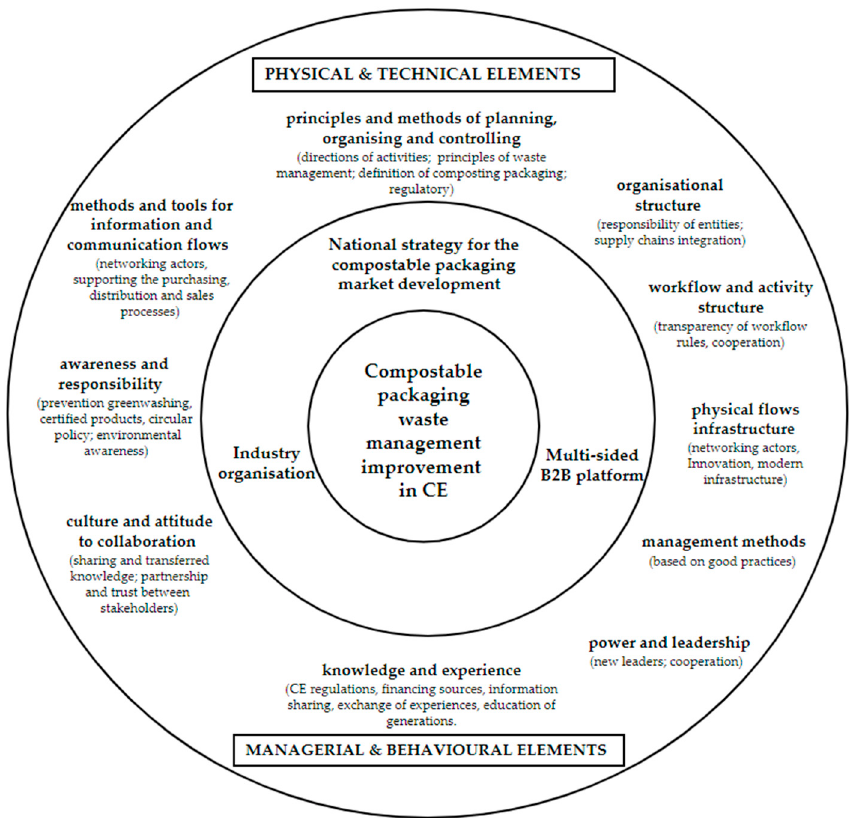
Figure 3. Multi-solution perspectives for improving compostable packaging waste management in CE. Source: own elaboration based on the SIL workshop results and literature review.